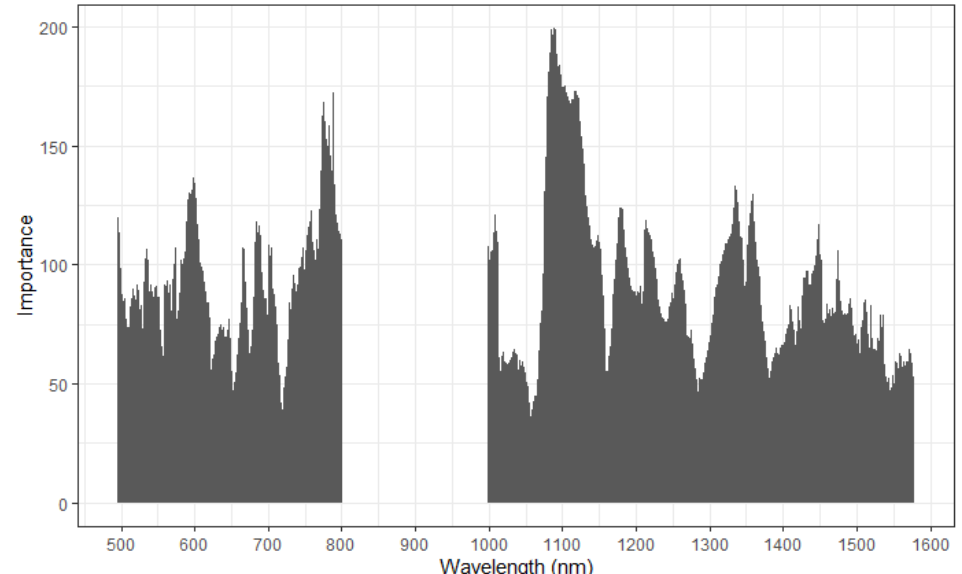
Figure 3. Variable importance for combination of visible (470.5–800.5 nm) and short-wave infrared (1000.5–1600.5 nm) spectra using partial least squares discriminant analysis to identify bovine and ovine organs by type.